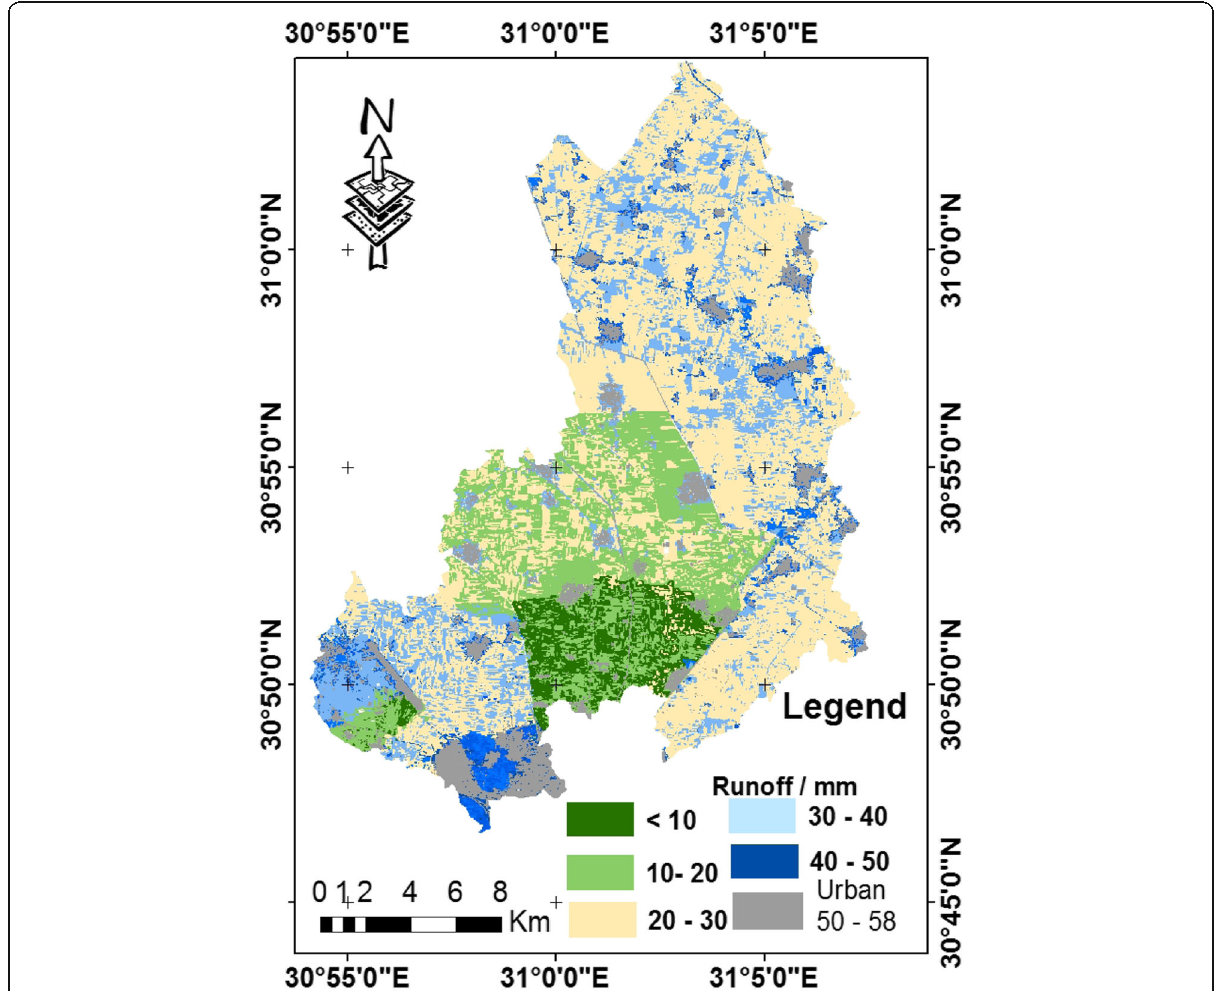
Fig. 7 Spatial distribution of runoff values for a rainfall of 58